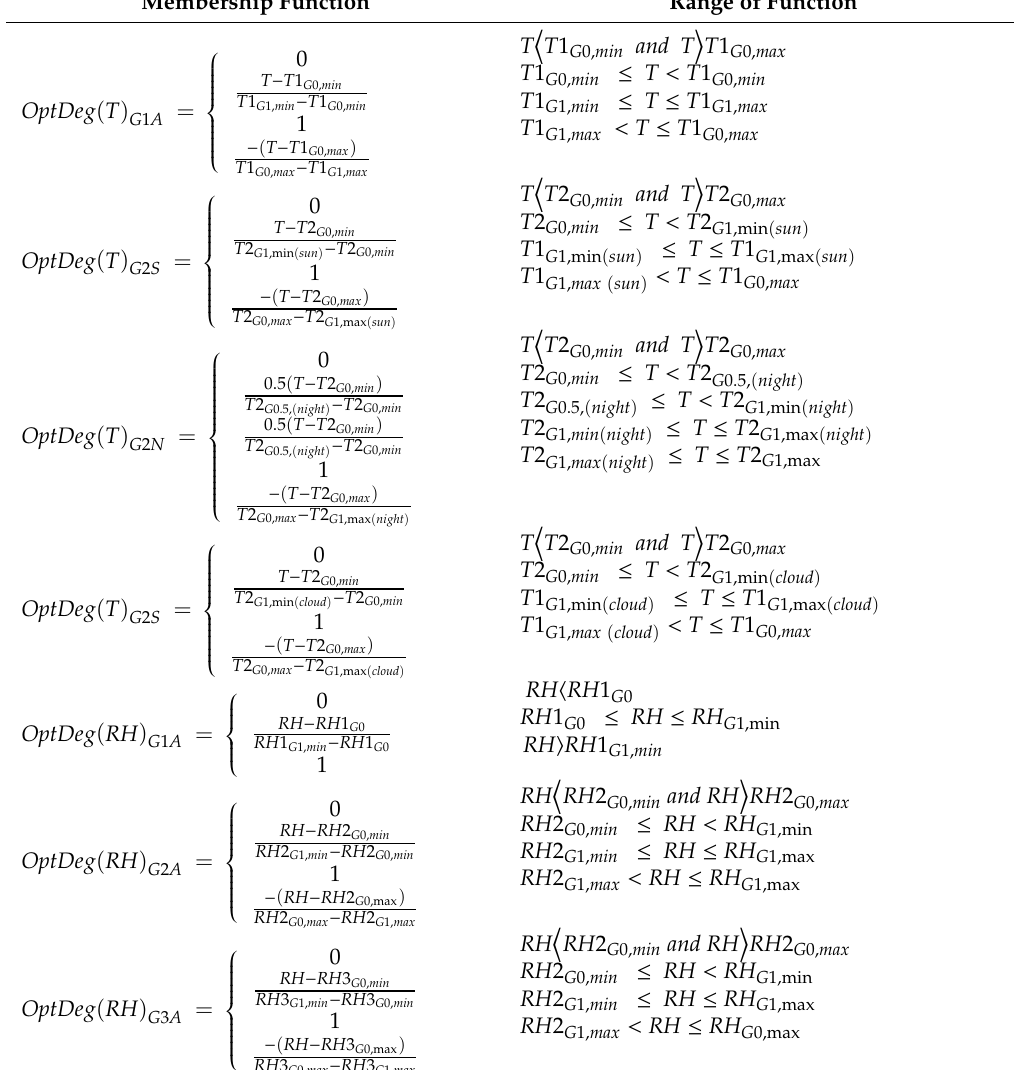
Table 2. Mathematical descriptions of the membership functions defining optimality degrees of air temperature, relative humidity [16,26,29]. G0: index of failure, G1: Growth stage1, G2: Growth stage2, G3: Growth stage3, A: All light conditions, N: Night, C: Cloud, S: